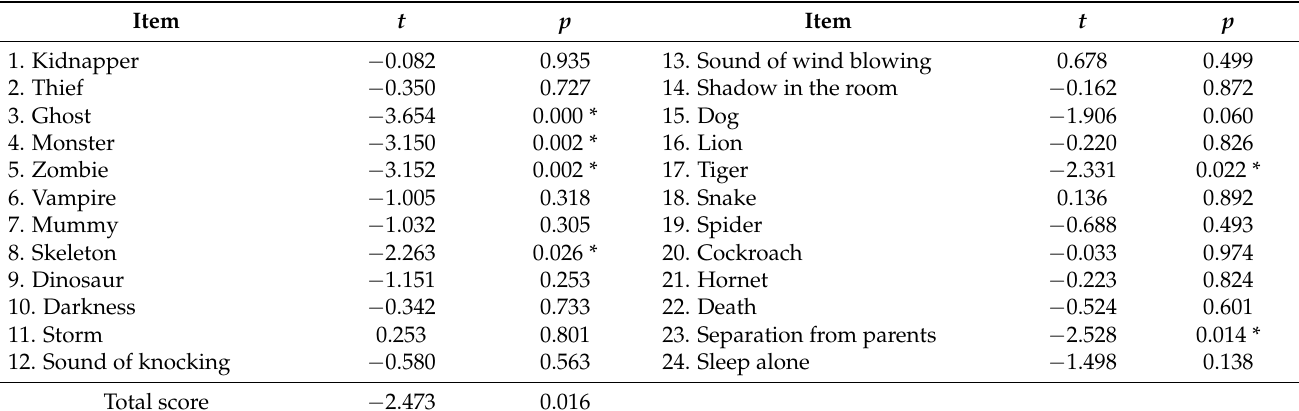
Table 10. Paired samples t -test of items in the experimental group and the control group.